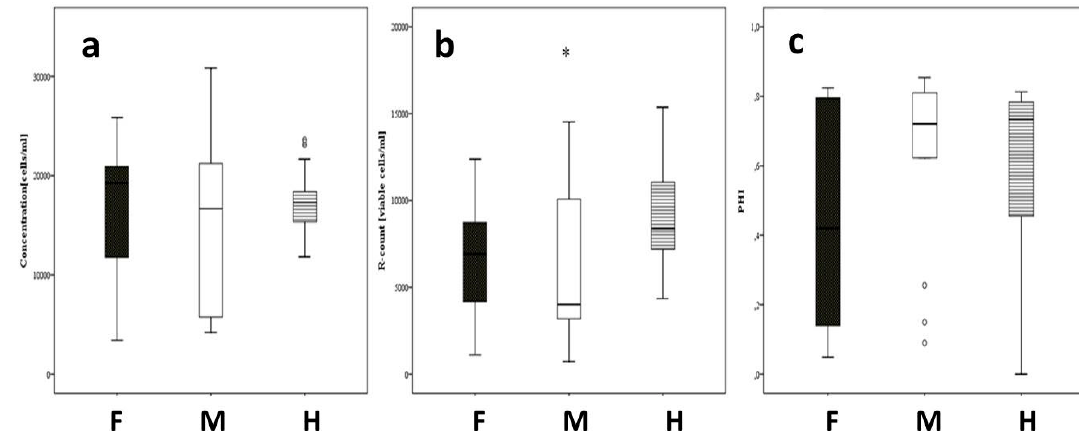
Figure 3. Boxplots showing the pollen amount (cells / mL) ( a ), viable pollen number (cells / mL) ( b ), Figure 3 Boxplots showing the pollen amount (cells/ml) ( a ), viable pollen number (cells/ml) ( b ), and 257 and panicle harvest index ( c ) for female lines, male lines and their hybrids for the climate chamber panicle harvest index ( c ) for female lines, male lines and their hybrids for the climate chamber stress 258 stress treatment the ratio between PHI stress / PHI control is 0.29 for females, 0.6 for males and 0.7 for treatment the ratio between PHI stress / PHI control is 0.29 for females, 0.6 for males and 0.7 for hybrids. 259 hybrids. * Significant at 0.05 level; ** Significant at 0.01 level; *** Significant at 0.001 level. Significance *Significant at 0.05 level; **Significant at 0.01 level; ***Significant at 0.001 level. Significance levels refer 260 levels refer to di ff erences between the groups hybrids and lines (females and males). F = female lines; to differences between the groups hybrids and lines (females and males). F=female lines; M=male lines; 261 M = male lines; H = hybrids H=hybrids 262 Table 5 Genotypic variances (mean squares) and their interactions for the traits pollen amount (cells/ml) 263 and viable pollen number (cells/ml) across the environments of Gross-Gerau and Rauischholzhausen. 264 Pollen traits were also scored in the field experiments of Gross-Gerau and Rauischholzhausen 2018. Since no cold stress occurred during this season, these experiments are regarded as ‘control field Items environments as previously outlined. Nevertheless, the entries ( n = 31) showed highly significant di ff erences for the scored traits pollen amount and viable pollen within all groups (lines, females, males and hybrids, Table 5, Table S3). Vice versa to the climate chamber experiments, under field conditions, the heritabilitywas higher for viable pollen than for pollen amount (Table